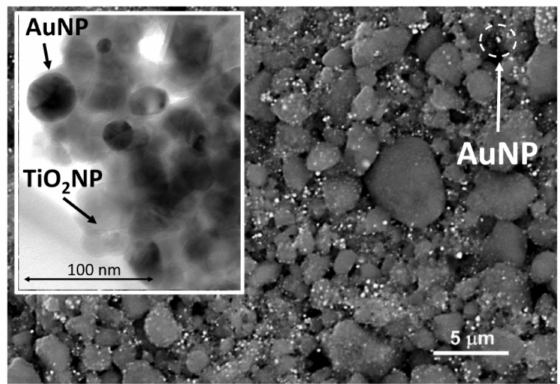
Figure 3. SEM-BSE micrograph of TiO 2 NP/AuNPs layer at 3500 × magnification. The HR-TEM image is reported in the inset.